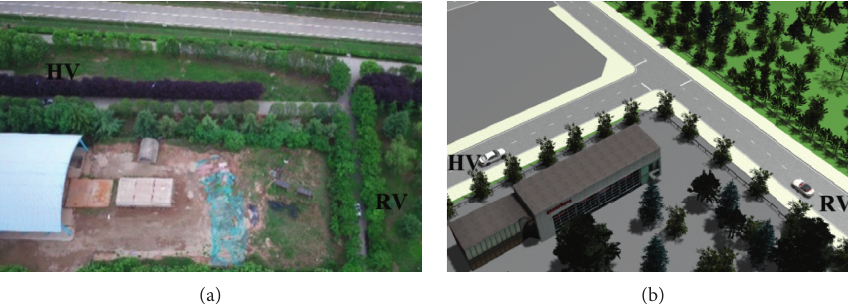
Figure 7: Building-shaded intersection scenario for the communication performance test. (a) Actual test scenario. (b) Virtual test scenario.